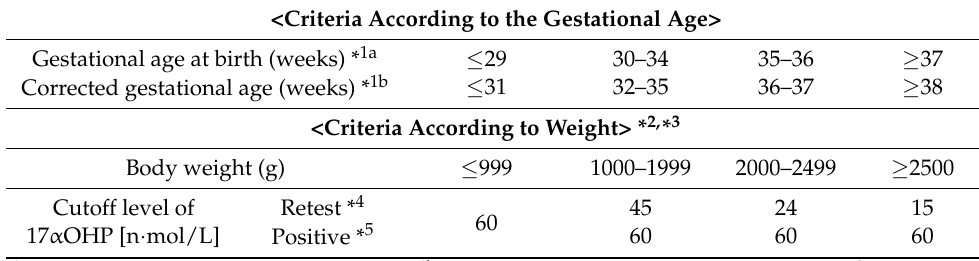
Table 1. Criteria of CAH mass screening in Tokyo.